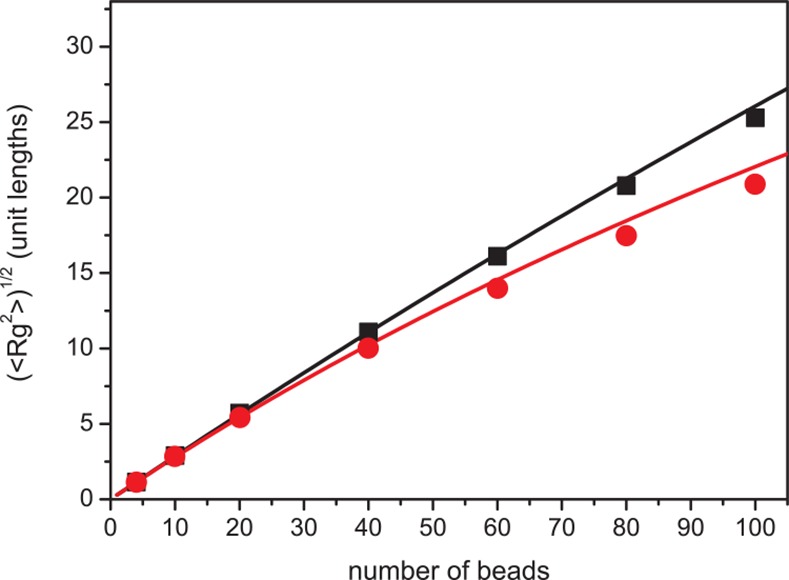
Dependency of the radius of gyration and the filament length for different persistence lengths.Single filaments of various lengths were simulated. After they have been equilibrated 2*109 sweeps were performed. If a maximal bond angel of 15° is allowed (black squares) we found a good agreement with the theoretical prediction for a worm-like chain with a lp of 1000 nm (black line). For a bond angle of 25° (red circle) a good comparison with the theoretical prediction for a worm-like chain with a lp of 333 nm (red line) was found.